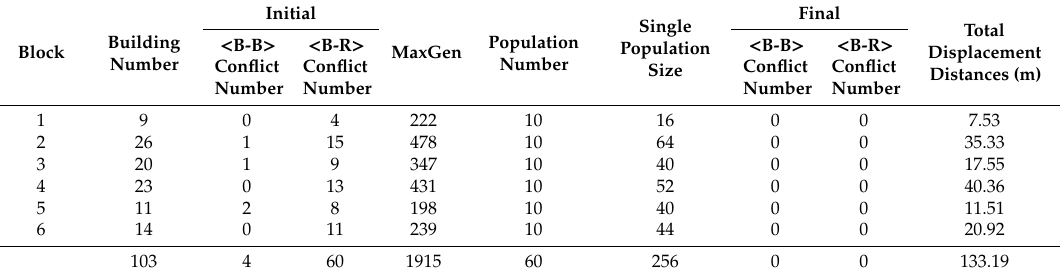
Figure 5. Comparison diagram. ( a ) Displacement result using the proposed BDMPGA (1:10,000); ( b ) Comparison of the initial data and displacement results based on the BDMPGA (1:10,000). Table 2. Statistical information of the displacement results based on the